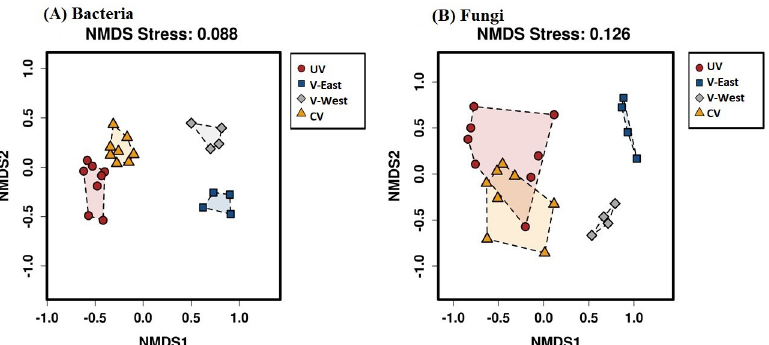
Fig 3. Non-metric multidimensional scaling (NMDS) plot displaying the community composition assignments of: (A) prokaryotic, and (B) fungi cross four sites. NMDS ordination of 24 samples across four sites was carried out based on Bray-Curtis dissimilarity distances calculated from pairwise taxonomic profile comparisons between all samples. A shorter linear distance between two samples denote greater similarity between the corresponding samples. Samples from four locations are presented by different colors (see